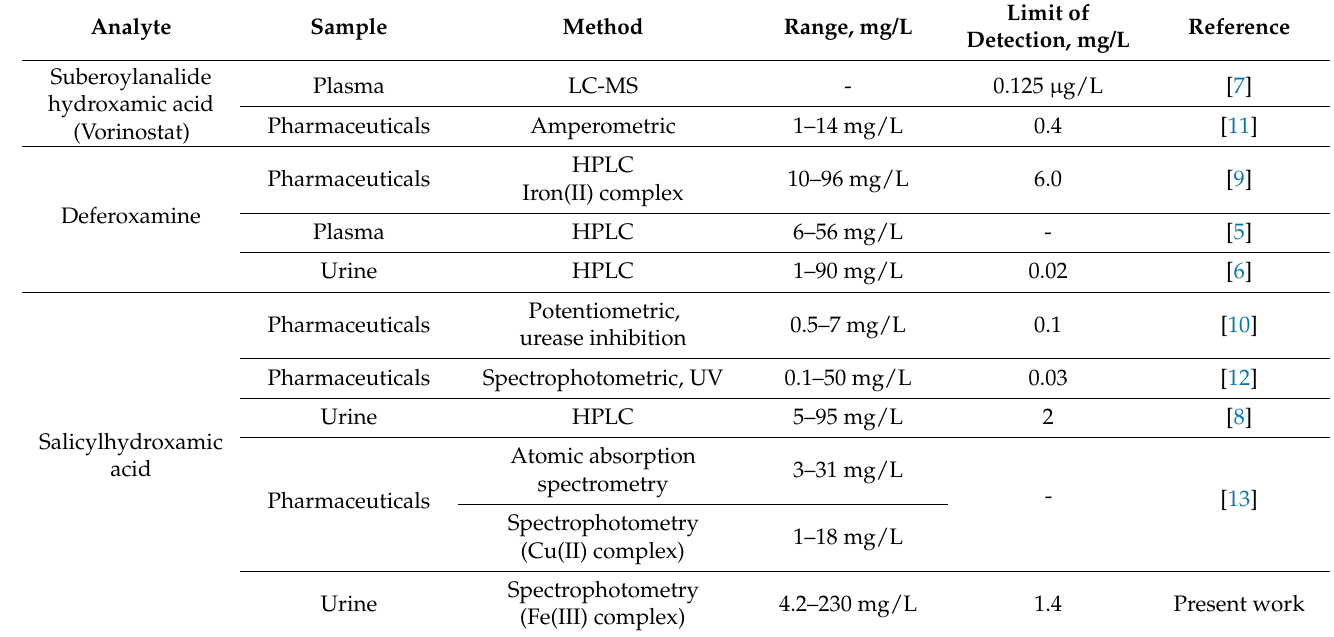
Table 4. Comparison of hydroxamic acids (HA) determination